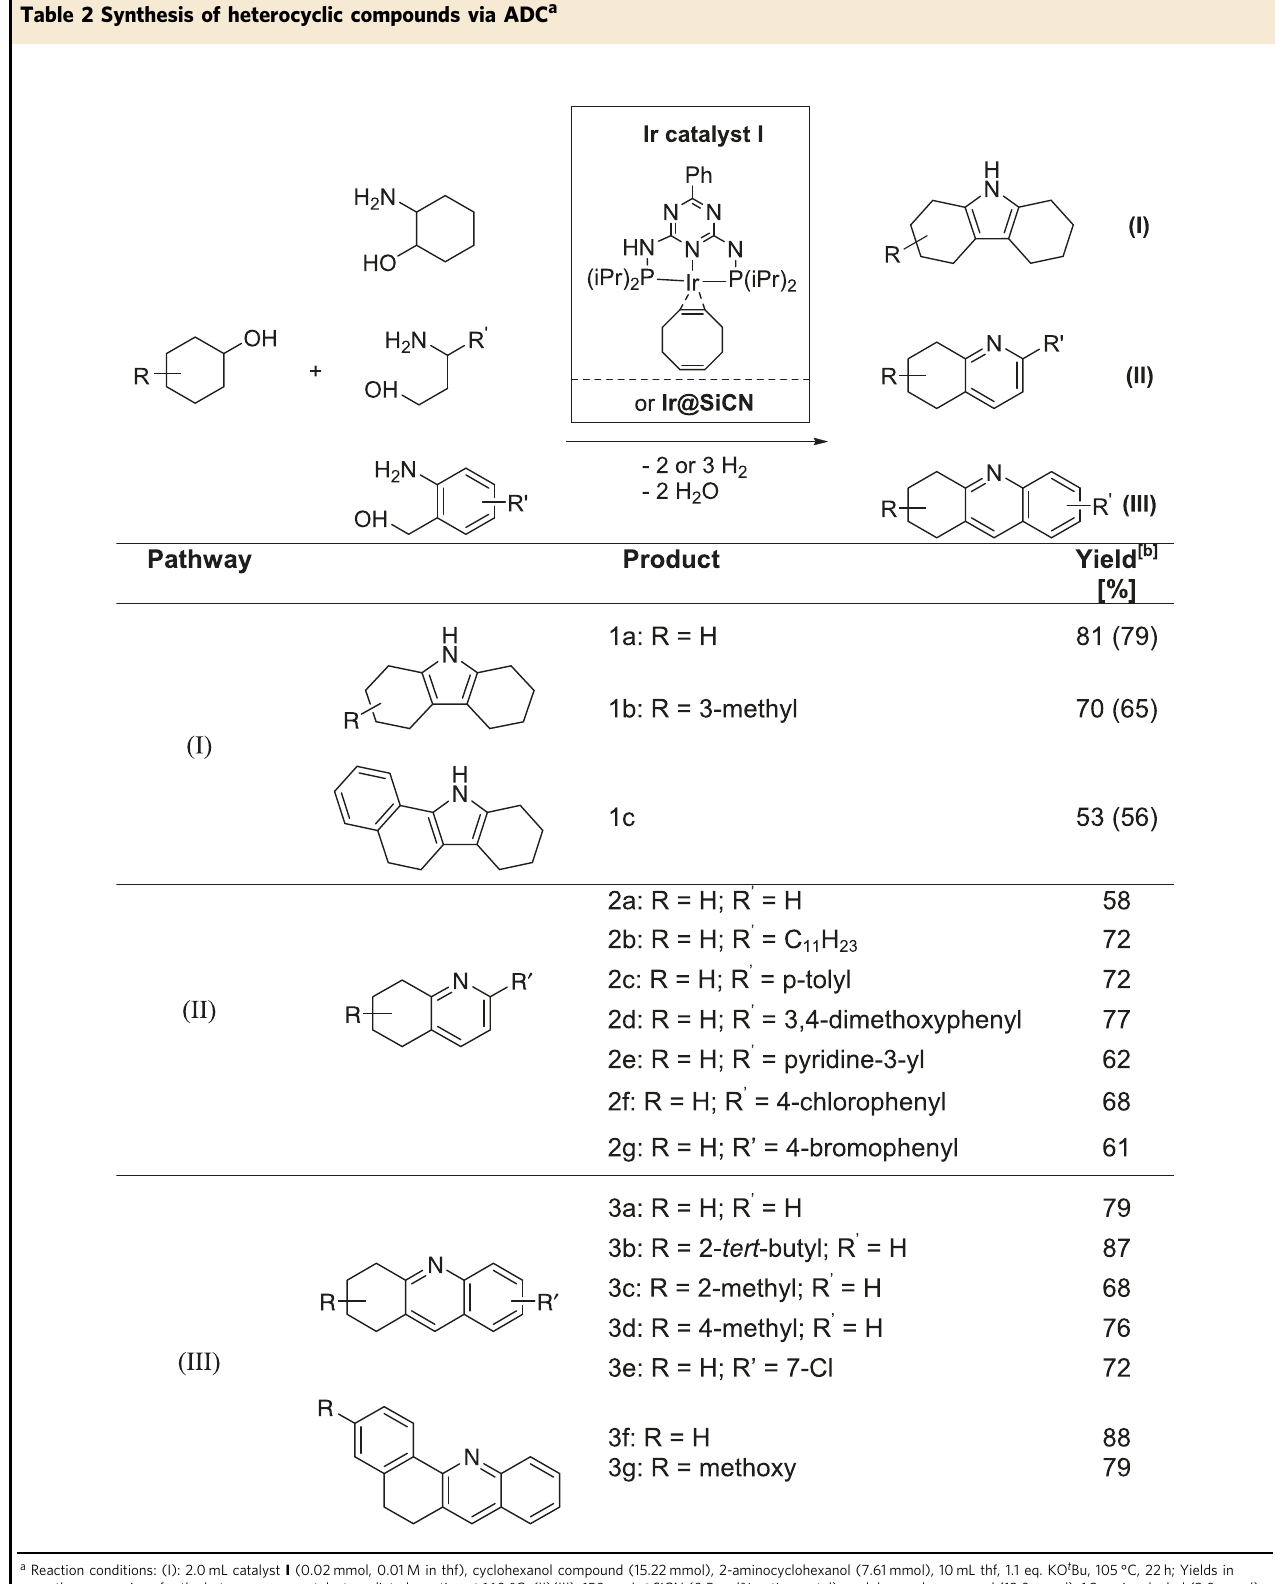
Table 2 Synthesis of heterocyclic compounds via ADC